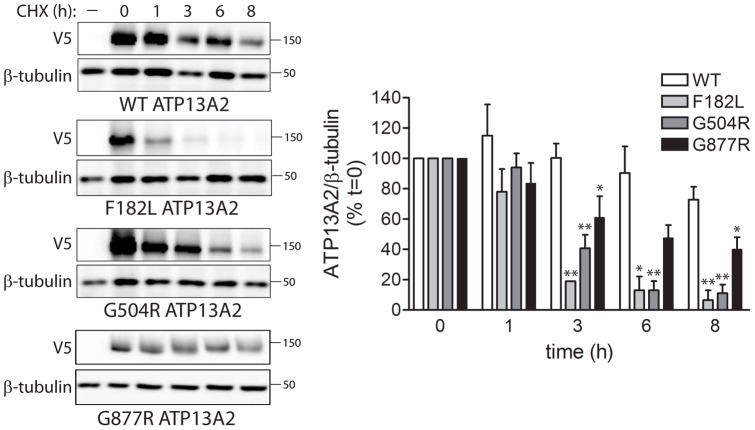
Homozygous missense mutations enhance the protein turnover of ATP13A2.Disease-associated homozygous mutations (F182L, G504R and G877R) enhance the turnover of ATP13A2. HEK-293T cells transiently expressing V5-tagged human ATP13A2 (WT or mutant) were treated with cycloheximide (CHX, 200 µg/ml) at 24 h post-transfection, and cells were harvested at 0, 1, 3, 6 and 8 h thereafter. Equivalent detergent-soluble extracts were probed with anti-V5 antibody to monitor ATP13A2 turnover, or with anti-β-tubulin antibody to demonstrate equal protein loading. Densitometric analysis indicates the markedly increased turnover of F182L, G504R and G877R variants compared to WT ATP13A2. The levels of ATP13A2 were normalized to β-tubulin. Bars represent ATP13A2 levels normalized to β-tubulin (mean±SEM; n = 3–4 experiments) expressed as a percent of time point ′0′ for each variant. *P<0.05 or **P<0.01 compared to WT ATP13A2 within each time interval by one-way ANOVA with Newman-Keuls post-hoc analysis.